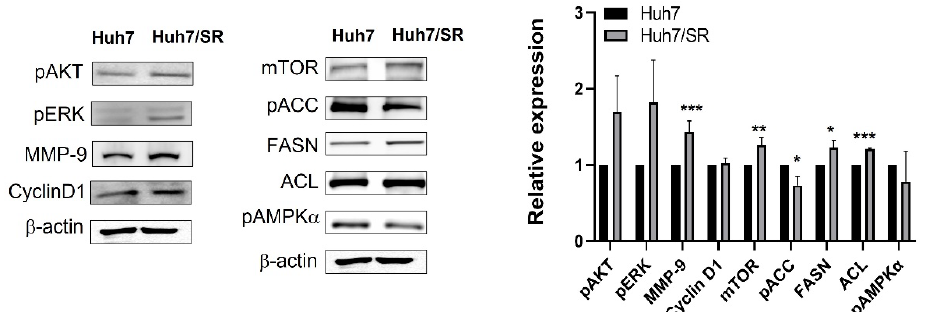
Figure 2. Huh7 and Huh7/SR cells show different protein expression profiles as determined by Western blot. Huh7/SR cells expressed higher pAKT, pERK, and MMP-9 related to cell survival and migration ability than Huh7 cells. Additionally, Huh7/SR cells showed elevated FASN, ACL, and mTOR correlated with fatty acid synthesis and metabolism. * p < 0.05; ** p < 0.01; *** p < 0.001.